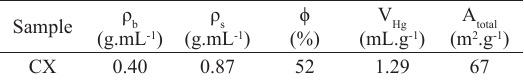
), skeletal density (ρ b ), total pore area (A Hg